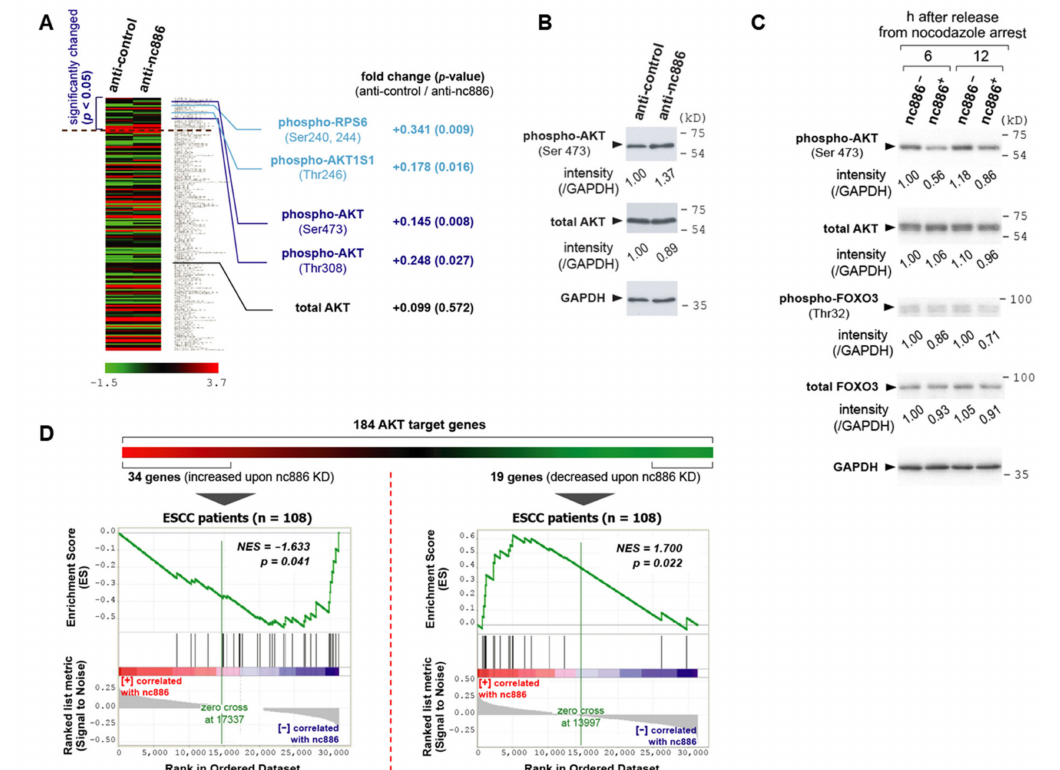
Figure 5. nc886 suppresses the AKT pathway. ( A ) A heat map showing the reverse-phase protein arrays (RPPA) data from nc886 KD of an ESCC cell line, TE1. RPPA values of a total of 172 proteins were sorted by p -values in descending order, to locate significantly ( p < 0.05) changed 23 proteins on the top. Fold change and p -values are shown for phospho- and total-AKT as well as AKT target proteins. ( B ) Western blot of phospho- and total-AKT together with GAPDH as a loading control after nc886 KD. Each indicated anti-oligo was transfected into an ESCC cell line, TE-8, and cells were harvested at 48 h after transfection. Each band was quantified with AlphaView software 2.0.1.1 (Alpha Innotech Corp, Santa Clara, CA) and normalized as indicated. ( C ) Western blot as described in panel B. nc886 − and nc886 + designate 293T-U6 and 293T-U6:nc886 cells respectively. These cells were synchronized by nocodazole, released from G2 / M arrest, and harvested at indicated times afterward. ( D ) GSEA to determine whether a priori defined set of AKT genes in nc886 KD shows statistical concordance in ESCC patients according to nc886